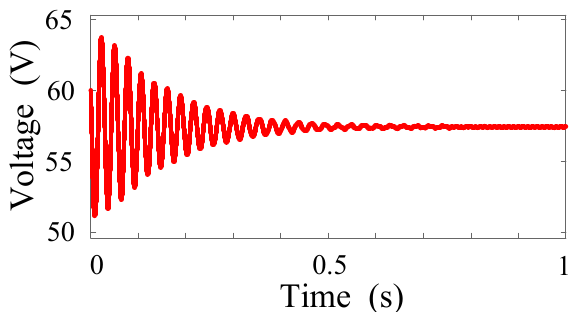
Figure 11. DC microgrid with three converters.